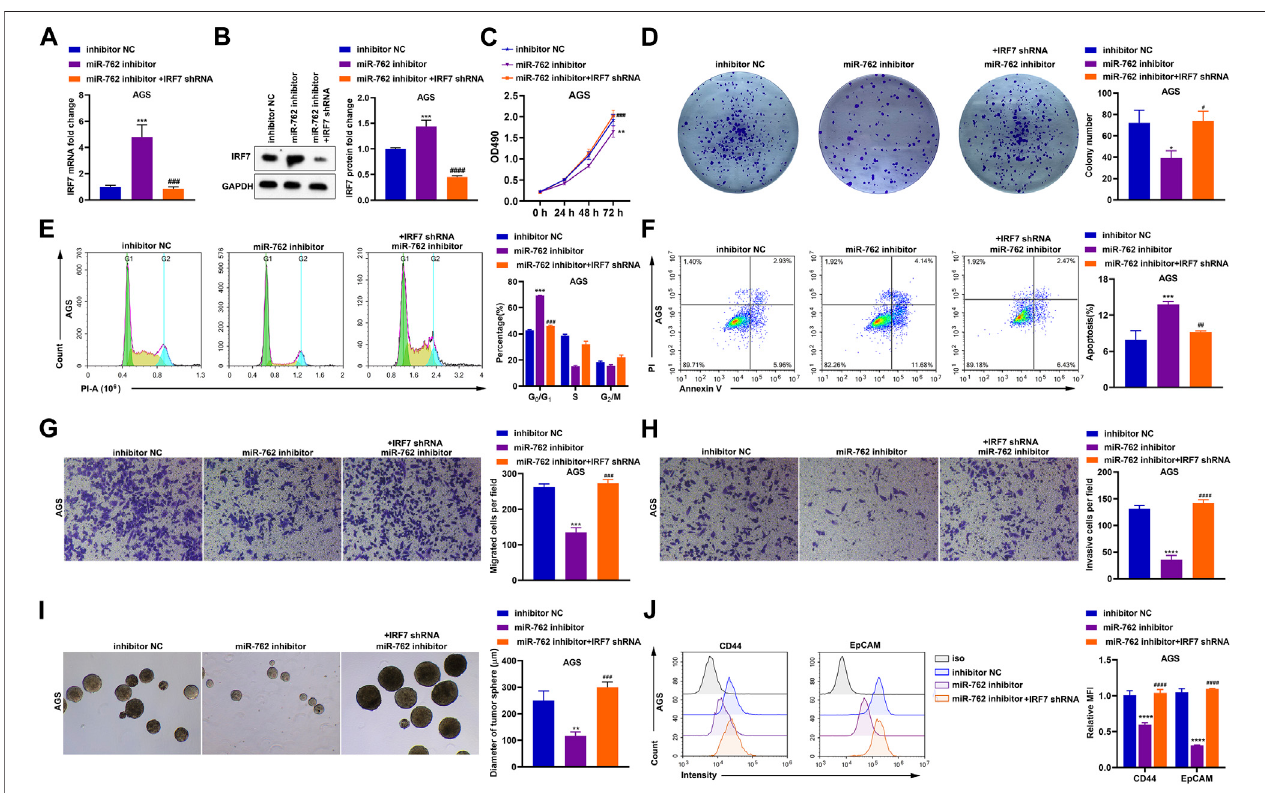
FIGURE 8 | The tumor-promoting function of miR-762 is dependent on the downregulation of IRF7 . (A) RT-qPCR detection of IRF7 mRNA expression in the presenceorabsenceof miR-762 inhibitoror IRF7 shRNA. (B) Representativeimagesandquanti fi cationofwesternblottingdetectionofIRF7proteinlevelinthepresence or absence of miR-762 inhibitor or IRF7 shRNA. (C) MTT analysis in AGS cells transfected with or without miR-762 inhibitor or IRF7 shRNA. (D) Representative images and quanti fi cation of colony formation result in the presence or absence of miR-762 inhibitor or IRF7 shRNA. (E) Representative images and quanti fi cation of cell cycle analysis in the presence or absence of miR-762 inhibitor or IRF7 shRNA. (F) Representative images and quanti fi cation of apoptosis analysis in the presence or absence of miR-762 inhibitor or IRF7 shRNA. (G , H) Representative images and quanti fi cation of transwell analysis for checking the migration (G) or invasion (H) in the presenceorabsenceof miR-762 inhibitoror IRF7 shRNA. (I) Representativeimagesandquanti fi cationoftumorsphereformationinthepresenceorabsenceof miR-762 inhibitor or IRF7 shRNA. (J) Flow cytometry quanti fi cation of CD44 and EpCAM expression in the presence or absence of miR-762 inhibitor or IRF7 shRNA.